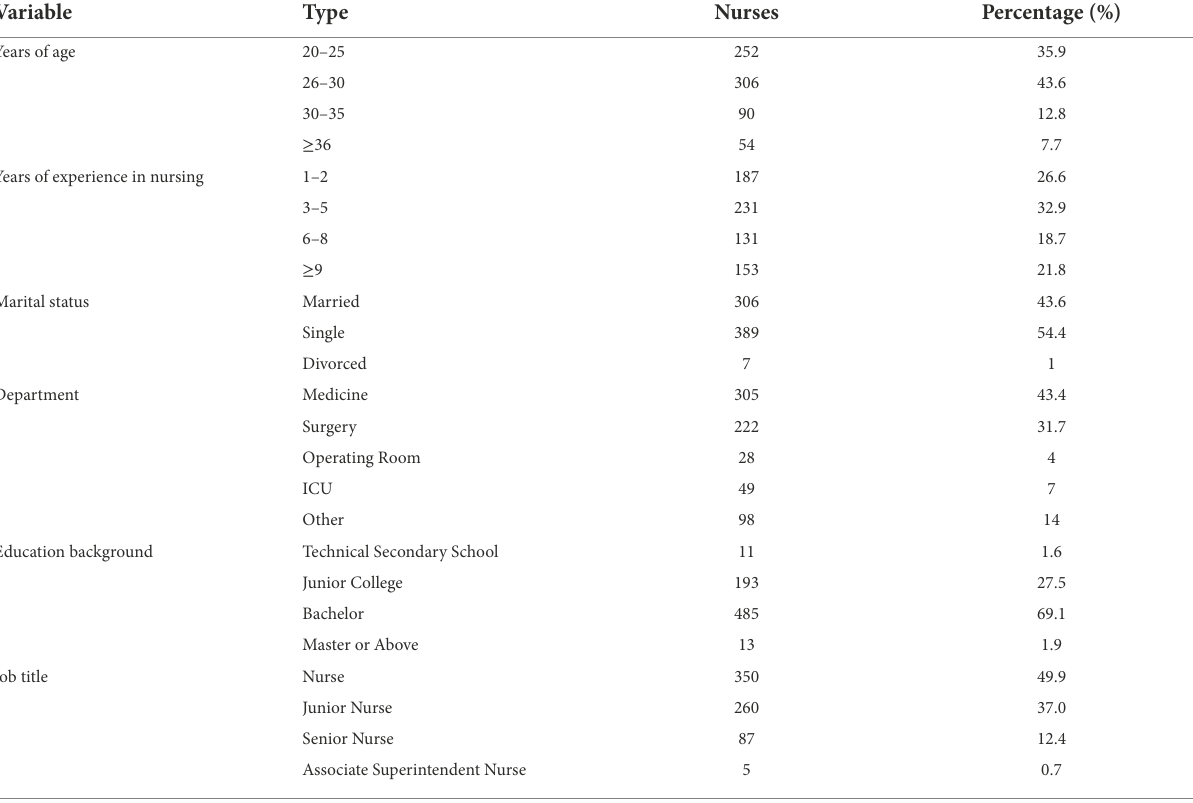
TABLE 1 Respondent demographics ( n = 702).